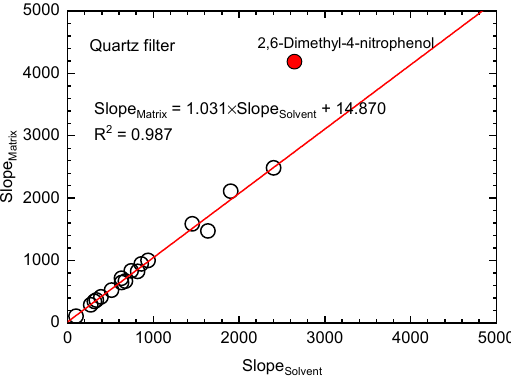
Figure 1. Regression of the matrix-matched calibration curve vs. solvent calibration curve slopes.